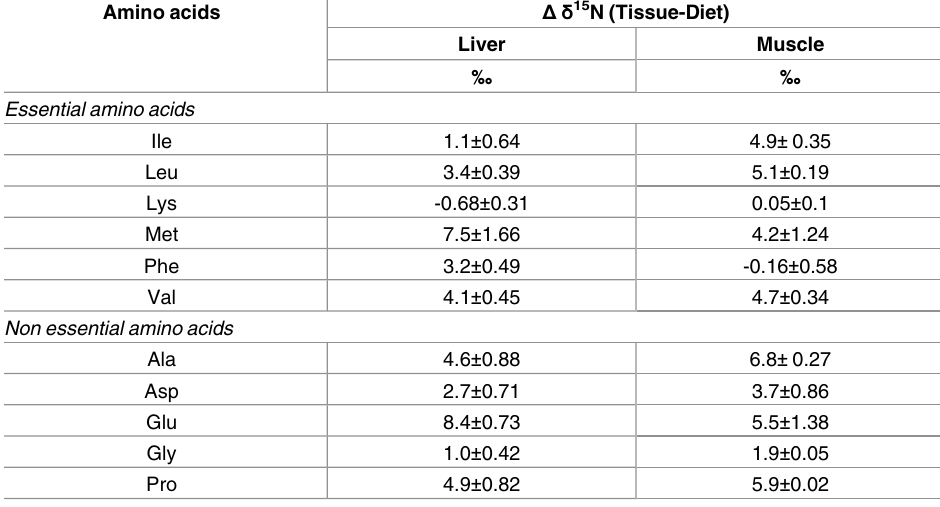
Table 4. 15 N enrichment of individual amino acids in liver and muscle tissue of S . lalandi fed a com- mercial